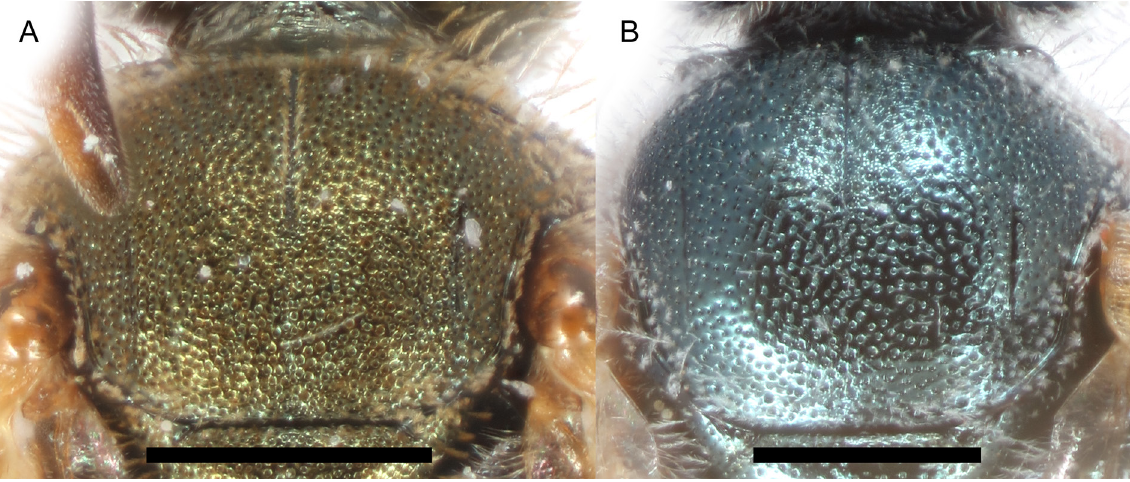
Fig. 110. Mesoscutum punctures. A . Lasioglossum ( D. ) vierecki (Crawford, 1904), ♂, all interspaces less than 1 puncture diameter. B . L. ( D. ) arenisaltans sp. nov., ♂, numerous interspaces of 1 puncture diameter or more. Scale bars: 0.5